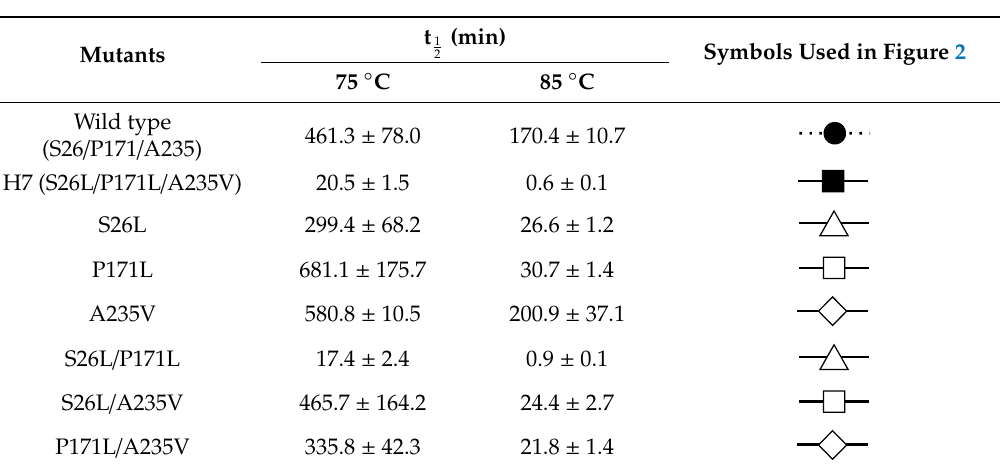
Symbols Used in Figure 2